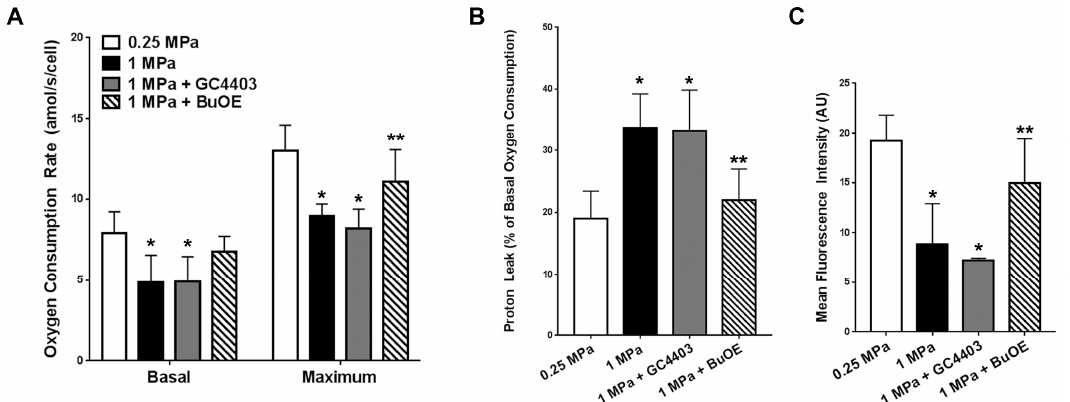
Figure 3. BuOE but not GC4403 prevents indications of mitochondrial dysfunction after repetitive compressive loading. ( A ) Mitochondrial stress test-derived basal and maximum oxygen consumption rates of chondrocytes extracted from the loaded portions of healthy 0.25 MPa loaded explants and injurious 1.0 MPa loaded explants with or without GC4403 or BuOE ( n = 4). ( B ) Proton leak by extracted chondrocytes as a percentage of the basal activity by each sample ( n = 4). ( C ) Overall mean fluorescence intensity of confocal images taken of cross sections of loaded portions of each explant staining with MitoTracker Deep Red ( n = 4). * indicate p < 0.01 compared to 0.25 MPa loading and ** indicate p < 0.01 compared to 1 MPa loading without treatment.